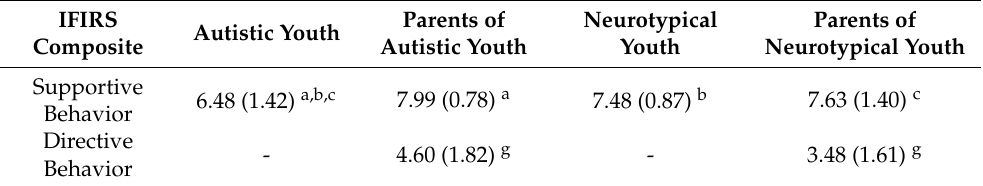
Table 2. Child and Parent IFIRS Composite Means by Diagnostic Group.